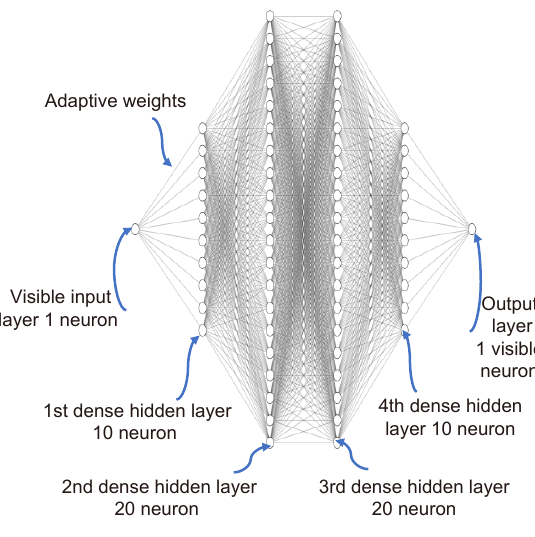
Fig. 13 | Deep Learning Model developed.